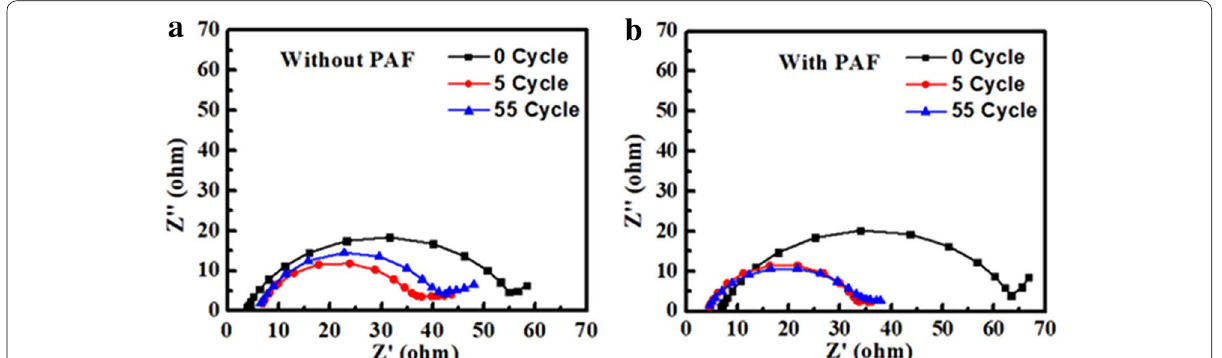
Fig. 5 Electrochemical impedance spectra of a Li/LFP full-cell LIB and b PAF-Li/LFP full-cell LIB after charge/discharge cycling at 1